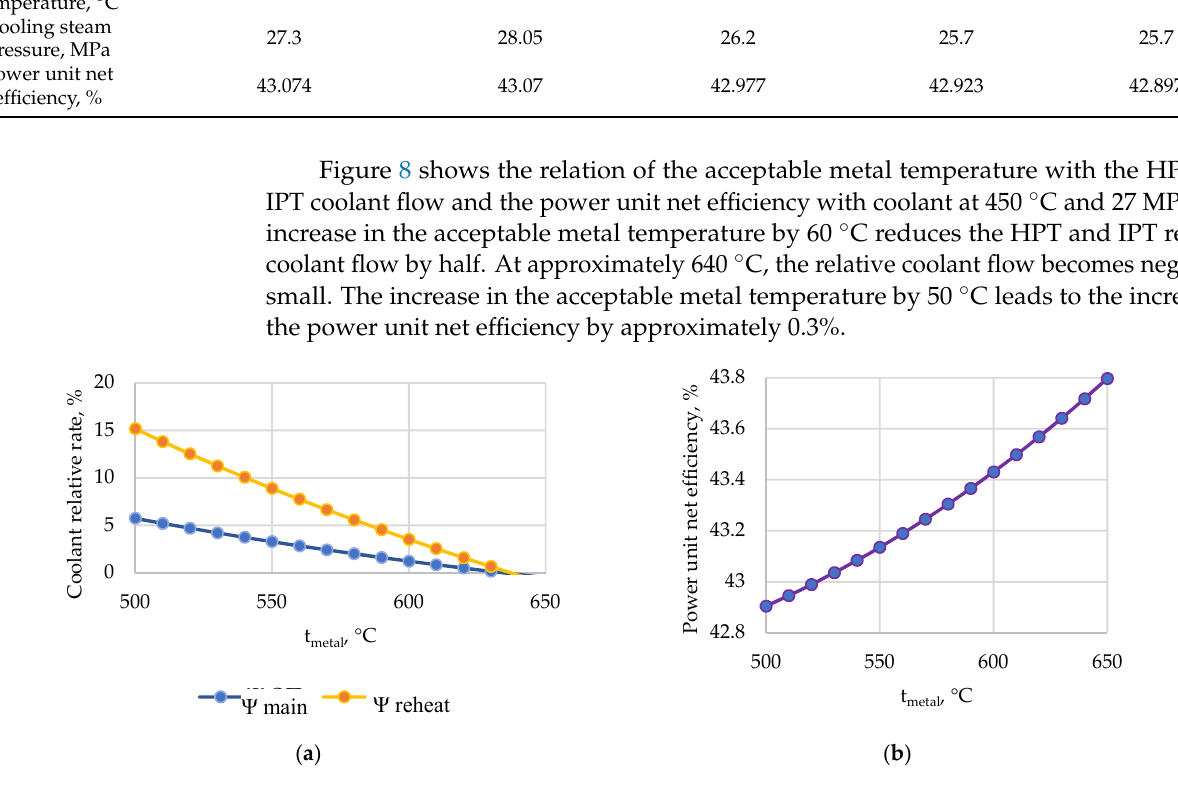
Figure 8. Dependences of the power unit operation parameters on the metal temperature at a 720 °C initial temperature and coolant at 450 °C and 27 MPa: ( a ) HPT and IPT coolant flow vs. metal temperature; ( b ) power unit net efficiency vs. metal temperature.